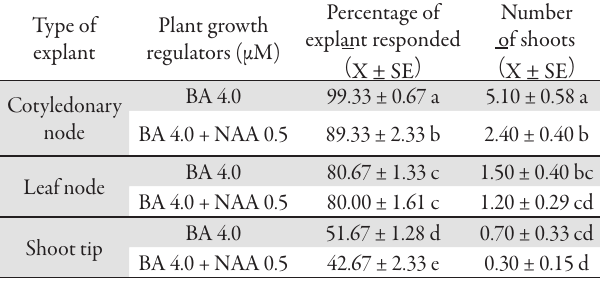
Note: Values represent means ± standard error of 20 explants per treatment in three repeated experiments. Means followed by the same letters are not significantly different by Duncan’s multiple Range Test at 0.05 % probability